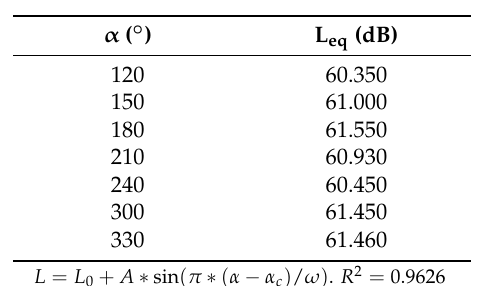
Table 8. Average Leq at OW-L [9].